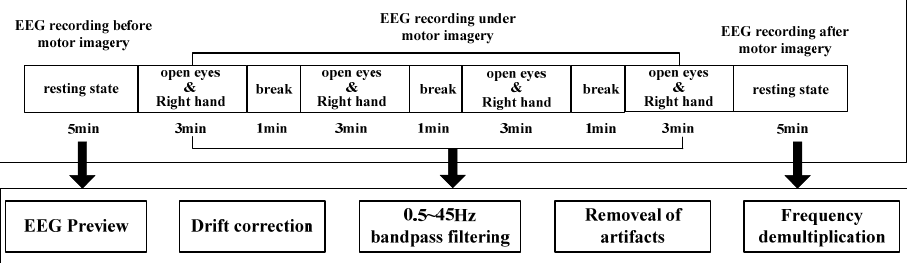
Figure 2. Experiment and data preprocessing.